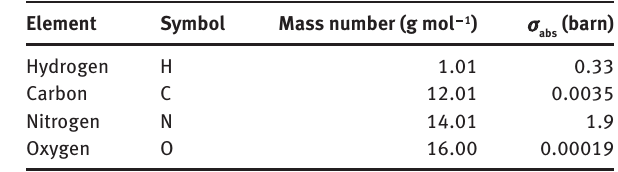
Table 2: Irradiation condition for neat epoxy in the reactor core. Sample